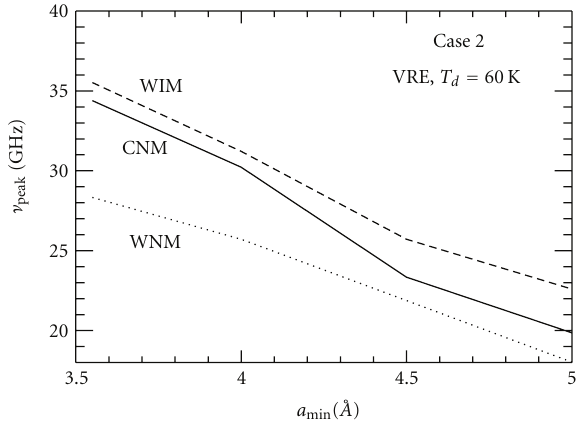
Figure 4: Emissivity per H obtained for WIM without ionic impulses using the Fokker-Planck equation from Ali-Ha¨ımoud et al. [12] and with impulses using our LE simulations for grain wobbling. The spectra are e ffi ciently broadened as a result of impulses (see blue line). The figure is reproduced from Hoang et al. [13].